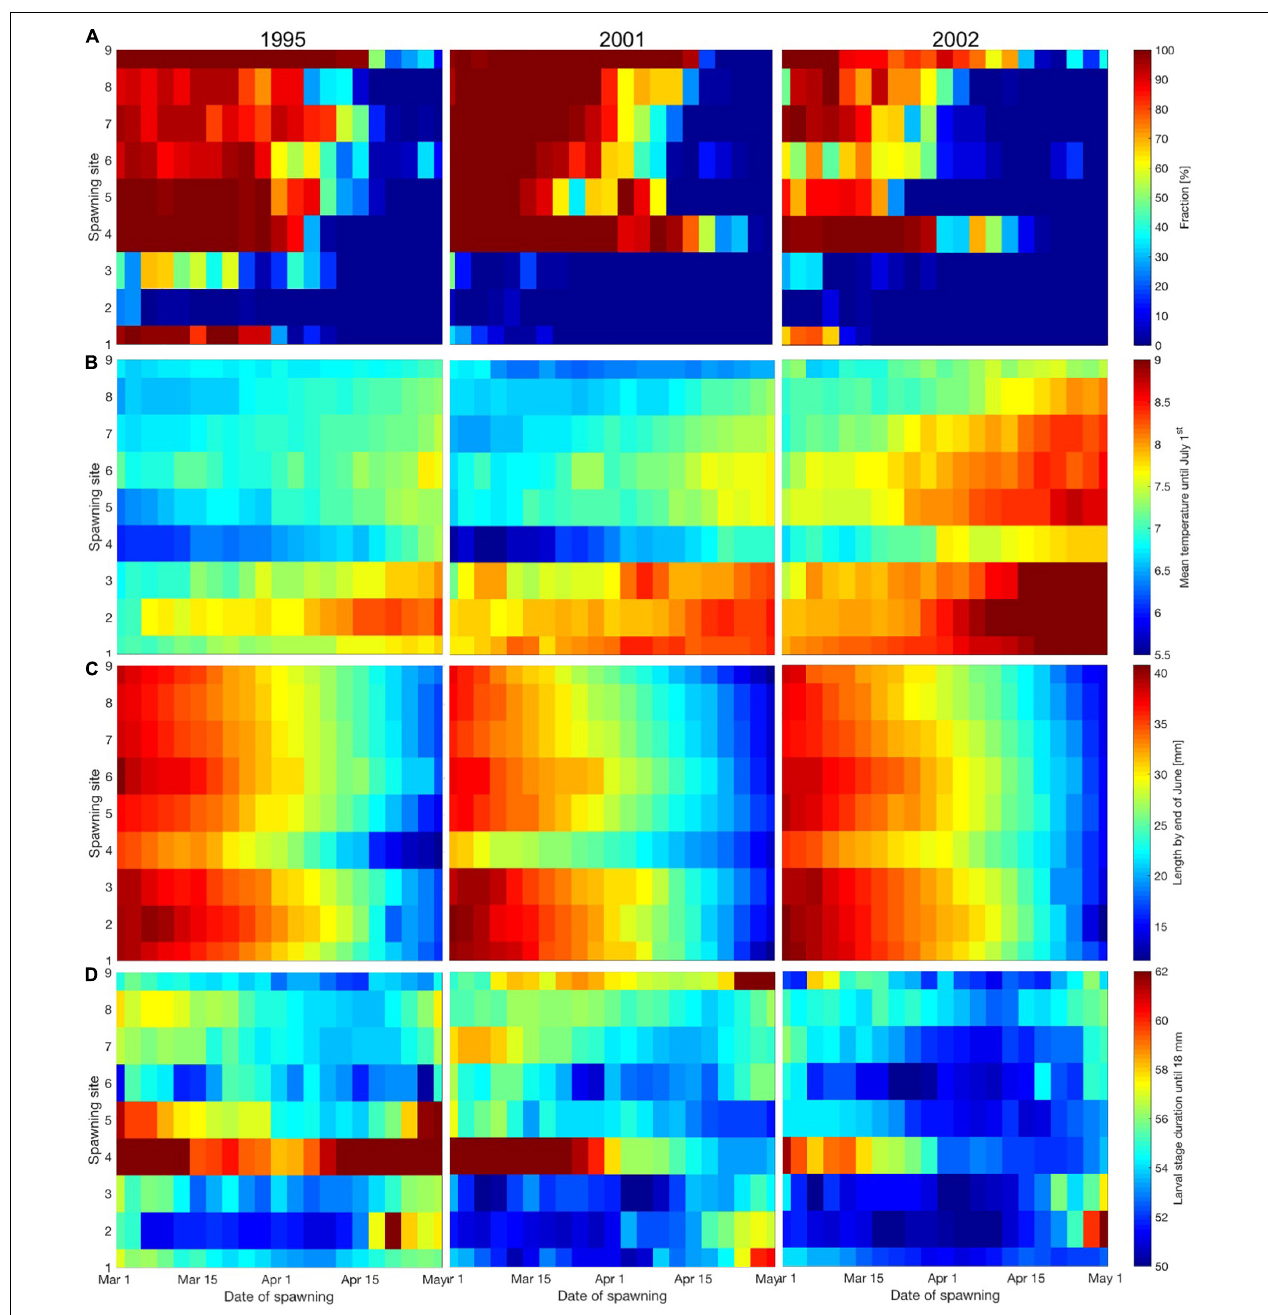
FIGURE 5 | Average (1995, 2001, and 2002) percentages of individual larvae and pelagic juveniles from each SG and ST across 1995, 2001, and 2002 that grow at more than 90% of their food-unlimited potential in more than 90% of the time (A) , mean larval ambient temperature (B) , larval length (mm) by the end of June (C) and larval stage duration (days) until the size of 18 mm (D)